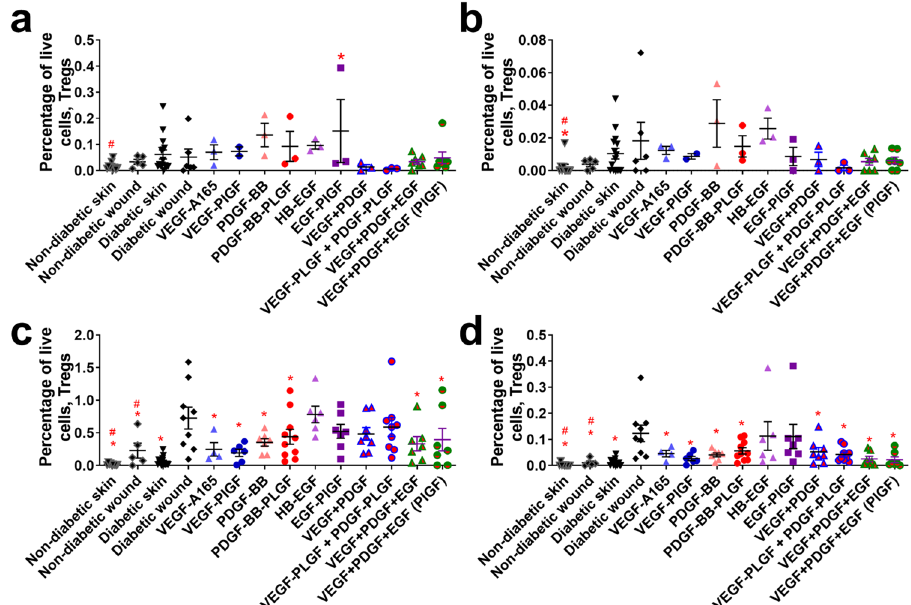
Fig. 8 T regulatory cell count in wounds after 3 – 7 days of healing. T-regulatory cells (CD45 + , CD3 + , CD4 + , CD25 high, Foxp3 + ) at ( a ) 3 days or ( c ) 7 days. Subset of effector T cells that are amphiregulin positive at ( b ) 3 days or ( d ) 7 days. Comparison includes unwounded skin from both the NOD and NOR mice. n ranges from 3 to 20. * Denotes comparison to the diabetic wound. # Denotes a comparison between untreated NOD wound and untreated NOR wound, and the WT GF(s) are compared to their counterpart -PLGF-2 123 – 144 variant(s), e.g., VEGF